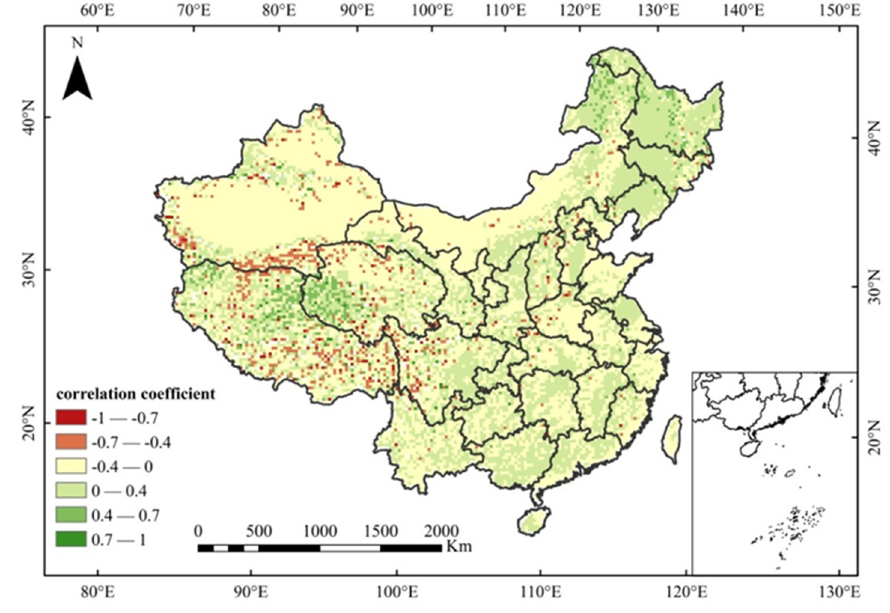
Figure 9. Correlation between annual TCO concentration and temperature.